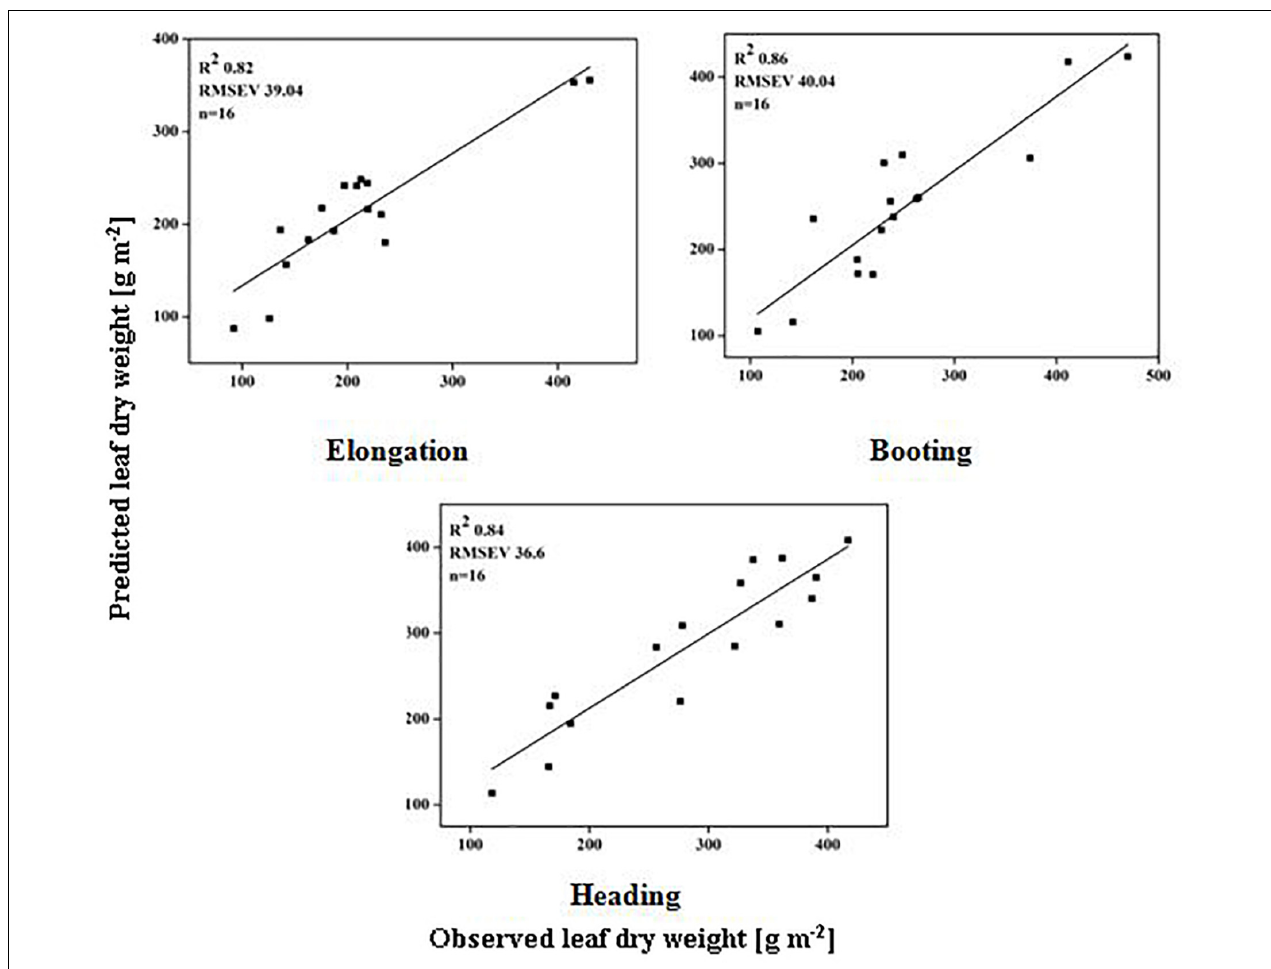
FIGURE 5 | Relationship between predicted and observed LDW (g m − 2 ) over phenological stages of rice.